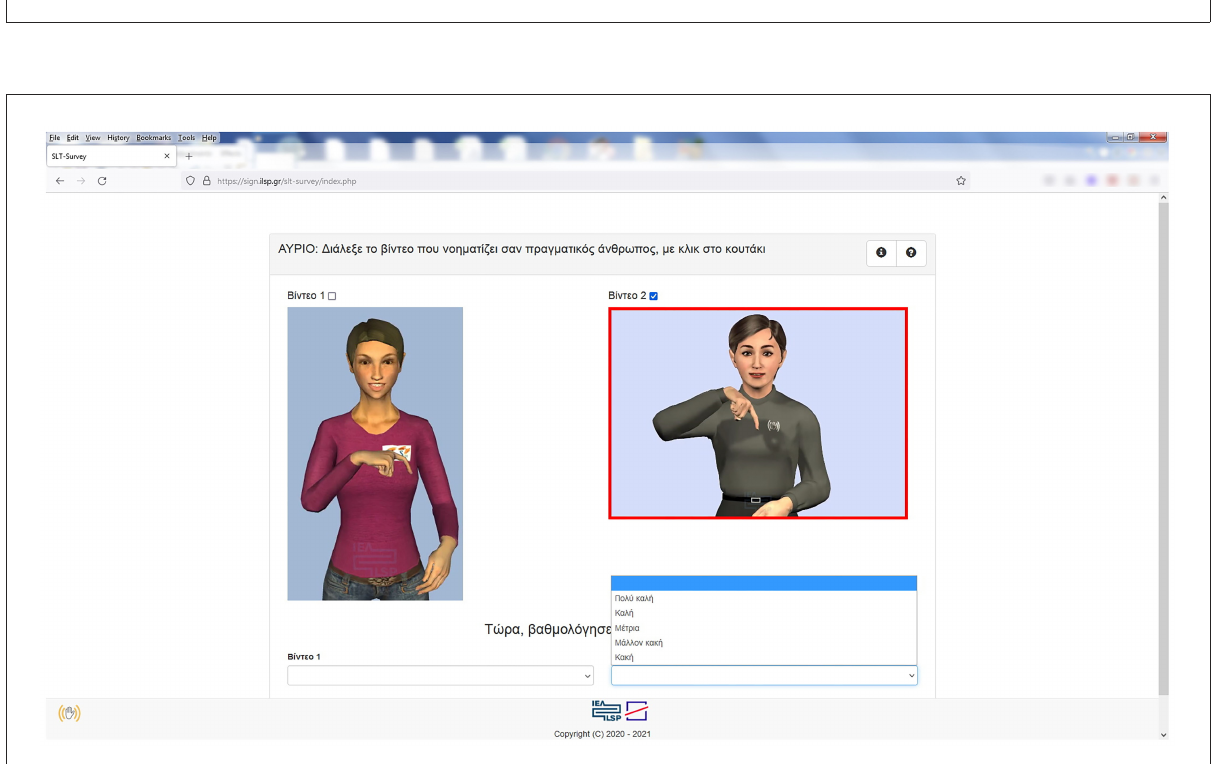
FIGURE2 Display of the same sign by the two avatars in part A of the questionnaire (Paula on the right, Françoise on the